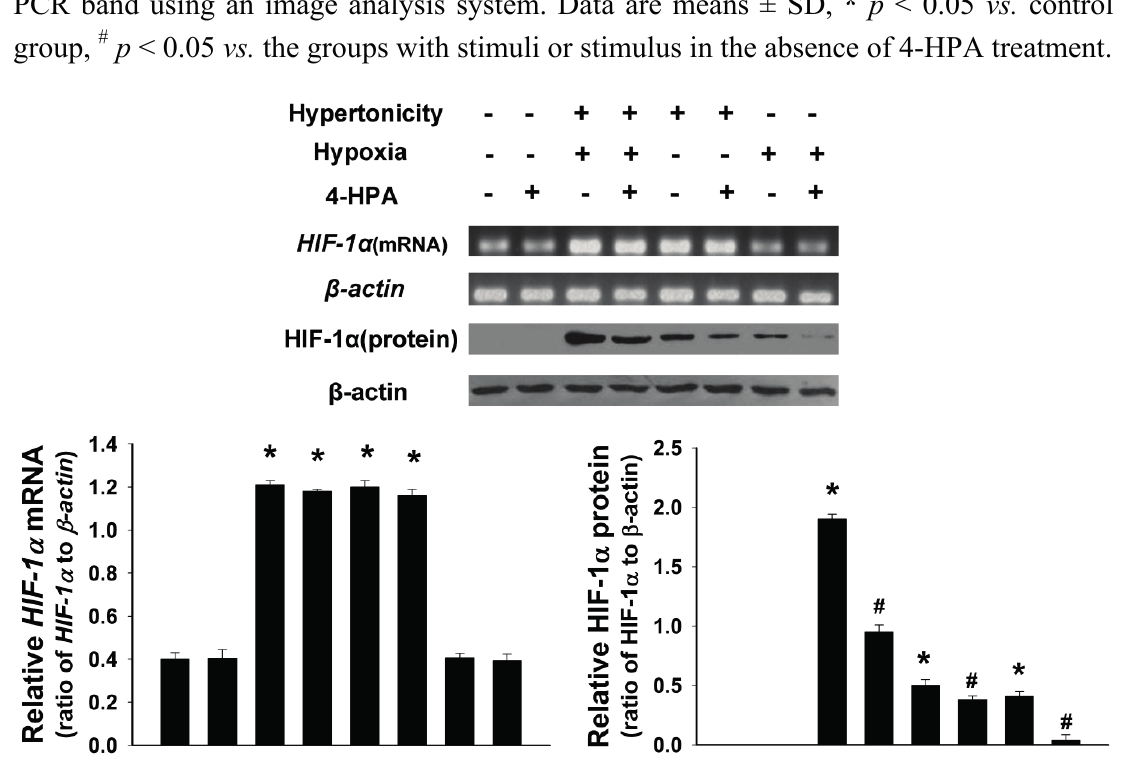
the Activations of Protein Translational Regulators, Including p70S6K1, S6 Ribosomal Protein, 4E-BP1, and eIF4E in Primary